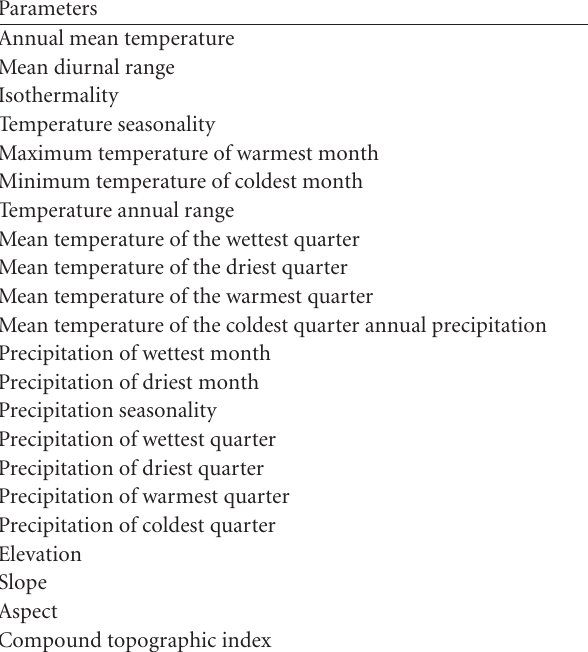
Table 2: Environmental parameters for species distribution mod-